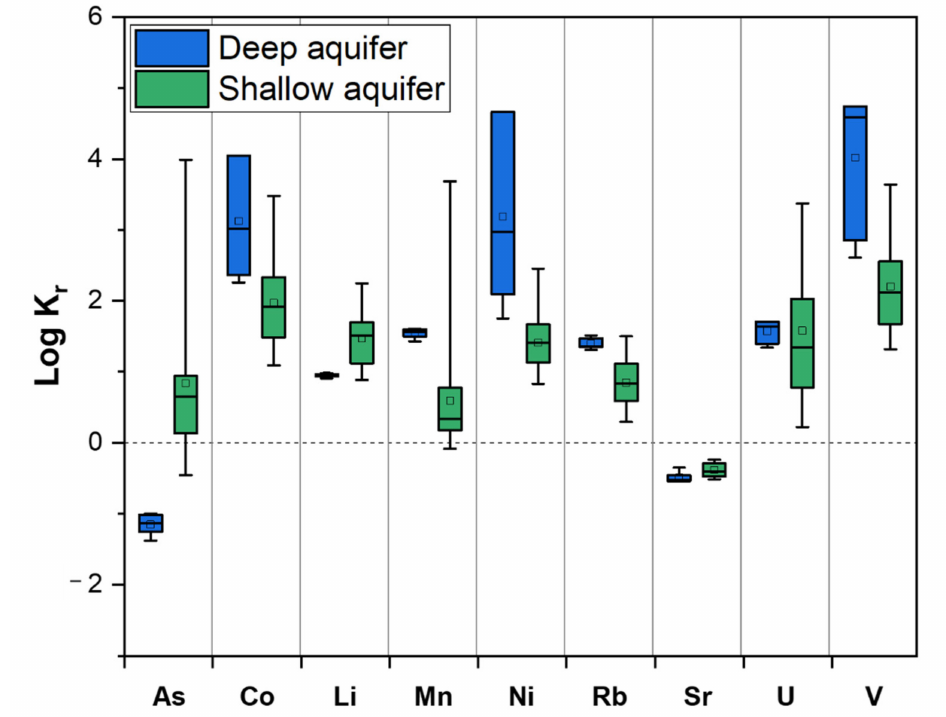
Figure 5. Range of K r values (in logarithmic scale) of the different trace elements analyzed in water samples of the shallow aquifer (indicated in green) and the deep aquifer (indicated in blue). Squares indicate the average value, horizontal lines the median value, boxes indicate the 25th–75th range, and whiskers indicate the minimum-maximum